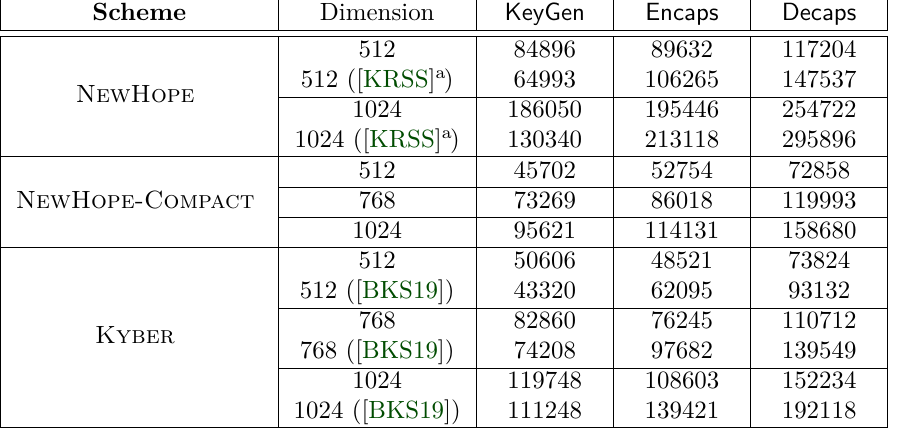
Table 7: Total time spent in polynomial multiplication subroutines ( NTT , NTT − 1 , and ◦